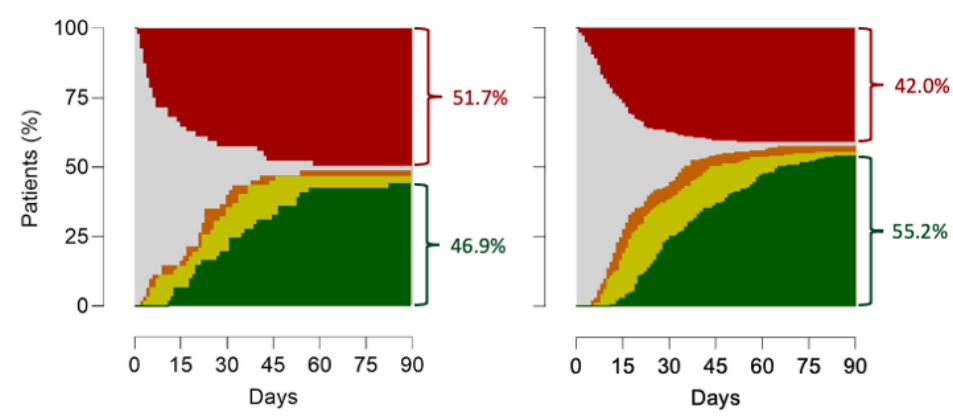
Figure 5. Outcomes. Patient outcomes for the groups of patients with an indication for prone positioning, on the left panel patients are displayed that did not receive prone positioning; on the right panel patients are displayed that did receive prone positioning. HR’s for outcomes were (no indication, no prone vs. no indication, prone vs. indication, no prone vs. indication, prone). 28-day mortality: 1.05 (0.76–1.45) vs. 0.88 (0.62–1.26) vs. 1.15 (0.80–1.54) vs. 0.96 (0.73–1.26) ( p = 0.08);